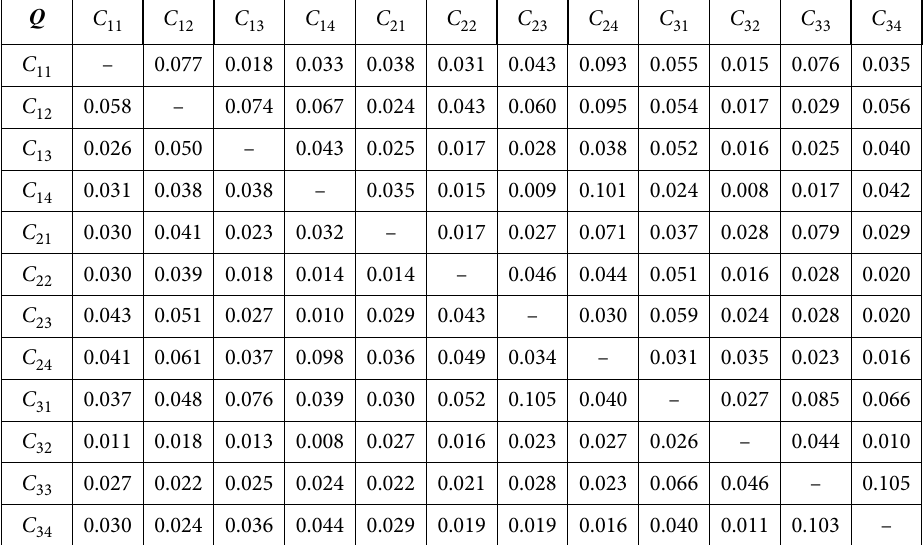
Figure 2. Analytical diagram of the empirical case Table 3. Initial influential significance-relation